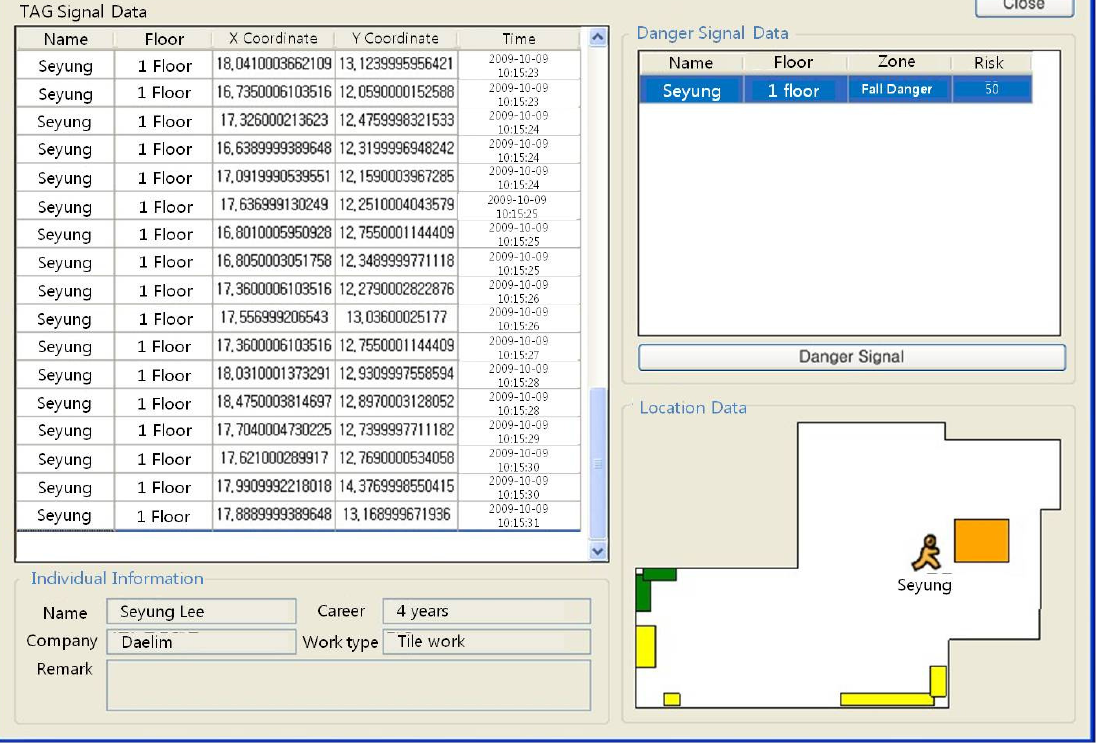
Fig. 7. Monitoring performance under a NLOS environment